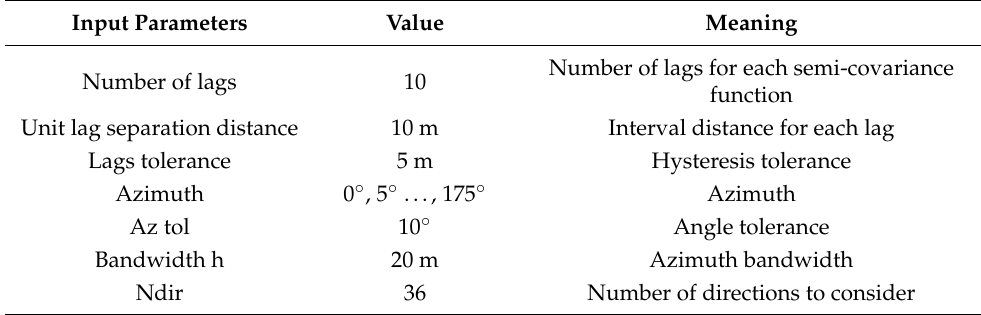
Table 1. The input parameters and values required when using GAMV program in